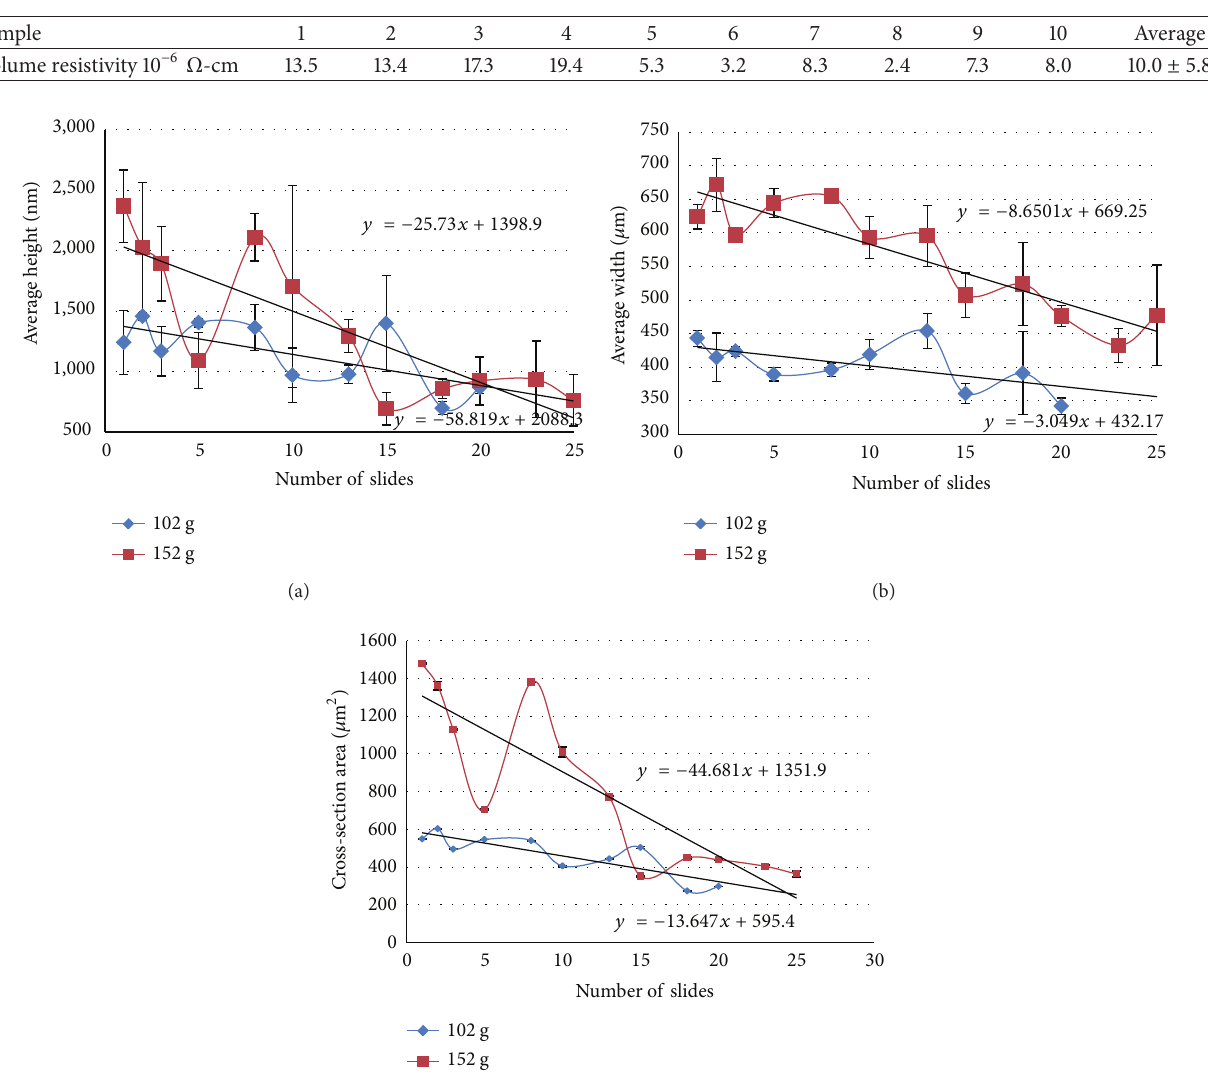
Table 1: Volume resistivity of a few IDE samples.